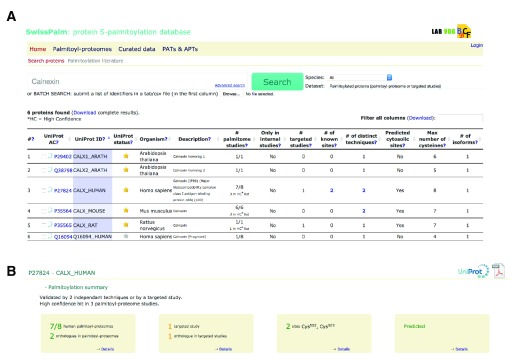
Search and result page.
A: SwissPalm search page: Example of query for “calnexin” shows that it has been found in palmitoyl-proteomes from several species: human (7 out of 8 screens), mouse (6 out of 6), rat (1 out of 1) and
Arabidopsis thaliana (1 out of 1). For human, mouse and rat calnexin was classified as a high confident hit and for human and mouse identified by two independent techniques (metabolic labeling and chemical capture). Finally, calnexin S-palmitoylation was also subject to targeted studies and 2 cysteine residues (502 and 503 in human calnexin) were identified.
B: Results Page from human calnexin display summary boxes containing the main information related to S-palmitoylation: number of occurrences in palmitoyl-proteome screens and targeted studies, sites information, cysteine prediction.